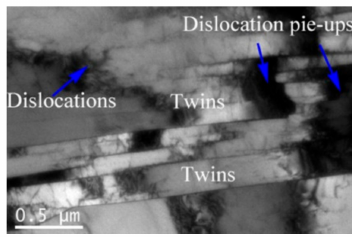
Figure 11. TEM morphology of the deformed superalloy at 1253 K, 0.01 s − 1 (The strain is 0.27.).